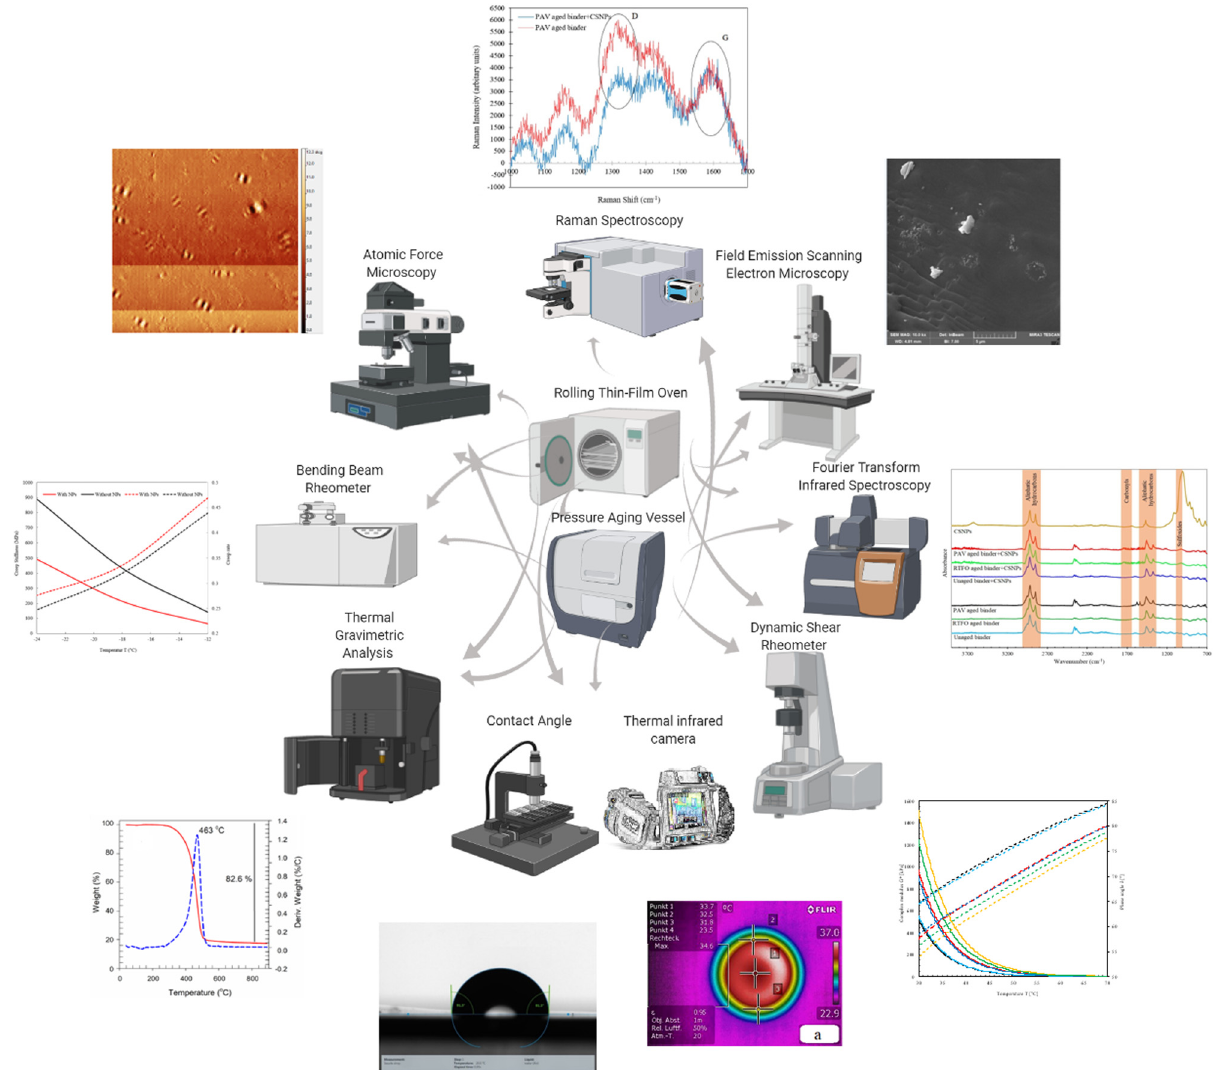
Figure 1: Schematic overview of experimental techniques applied in this